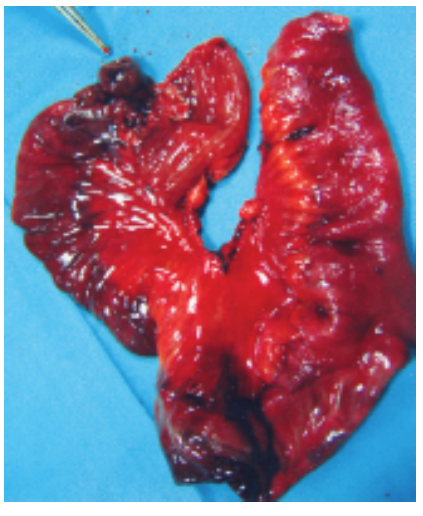
The intussuscepted tract